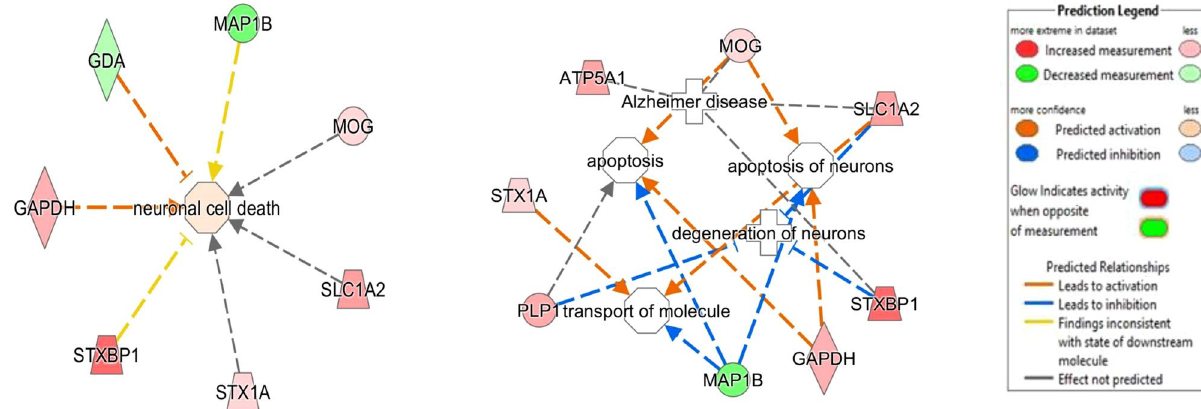
Figure 6. Diseases and functions associated with differentially expressed proteins implicated in AD prefrontal cortex. IPA constructs identified relationships between the differentially expressed proteins and associated disorders. Neuronal degeneration and cell death, apoptosis and transport of molecules are the chiefly disturbed pathways in Alzheimer’s